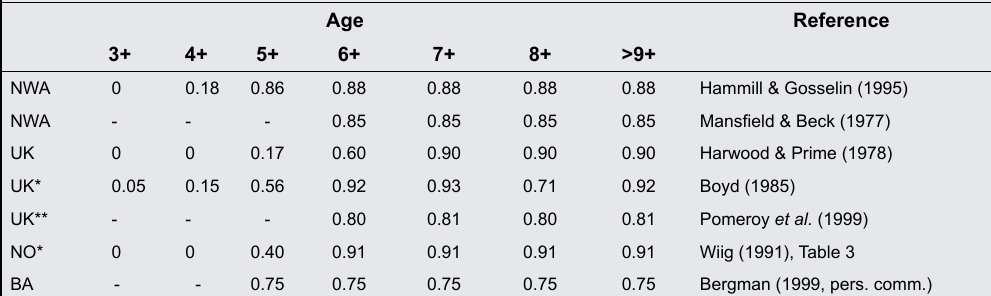
Grey seals in the North Atlantic and the Baltic